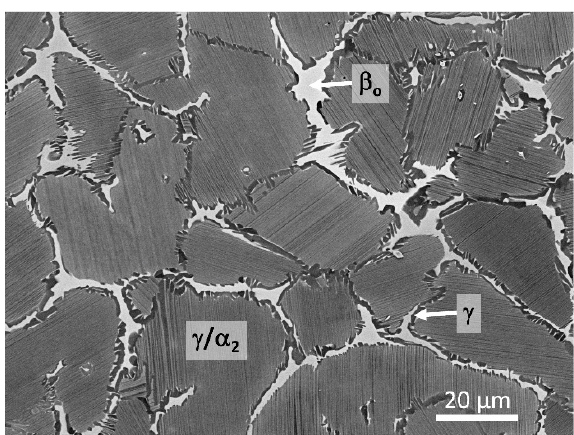
Figure 1. Microstructure of the investigated TNM alloy in the forged condition. The lamellar colonies consist of γ (dark contrast) and α 2 (light contrast) laths. The surrounding phases are γ and β o (bright contrast). Scanning electron microscope image taken in back-scattered electron mode.